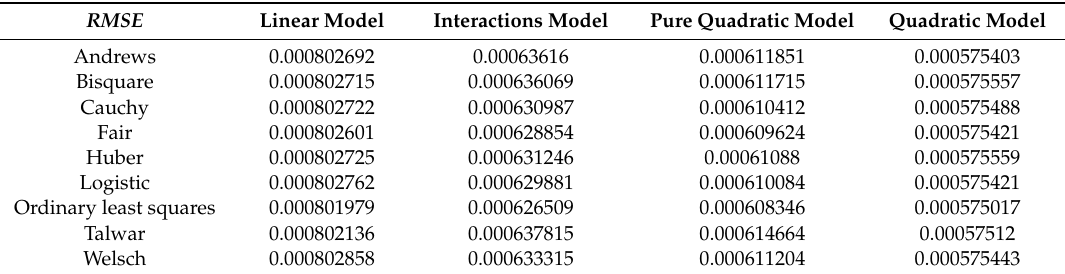
Table 4. The RMSE of the combination models of four kinds of model specification parameters and nine kinds of robust weight function parameters.